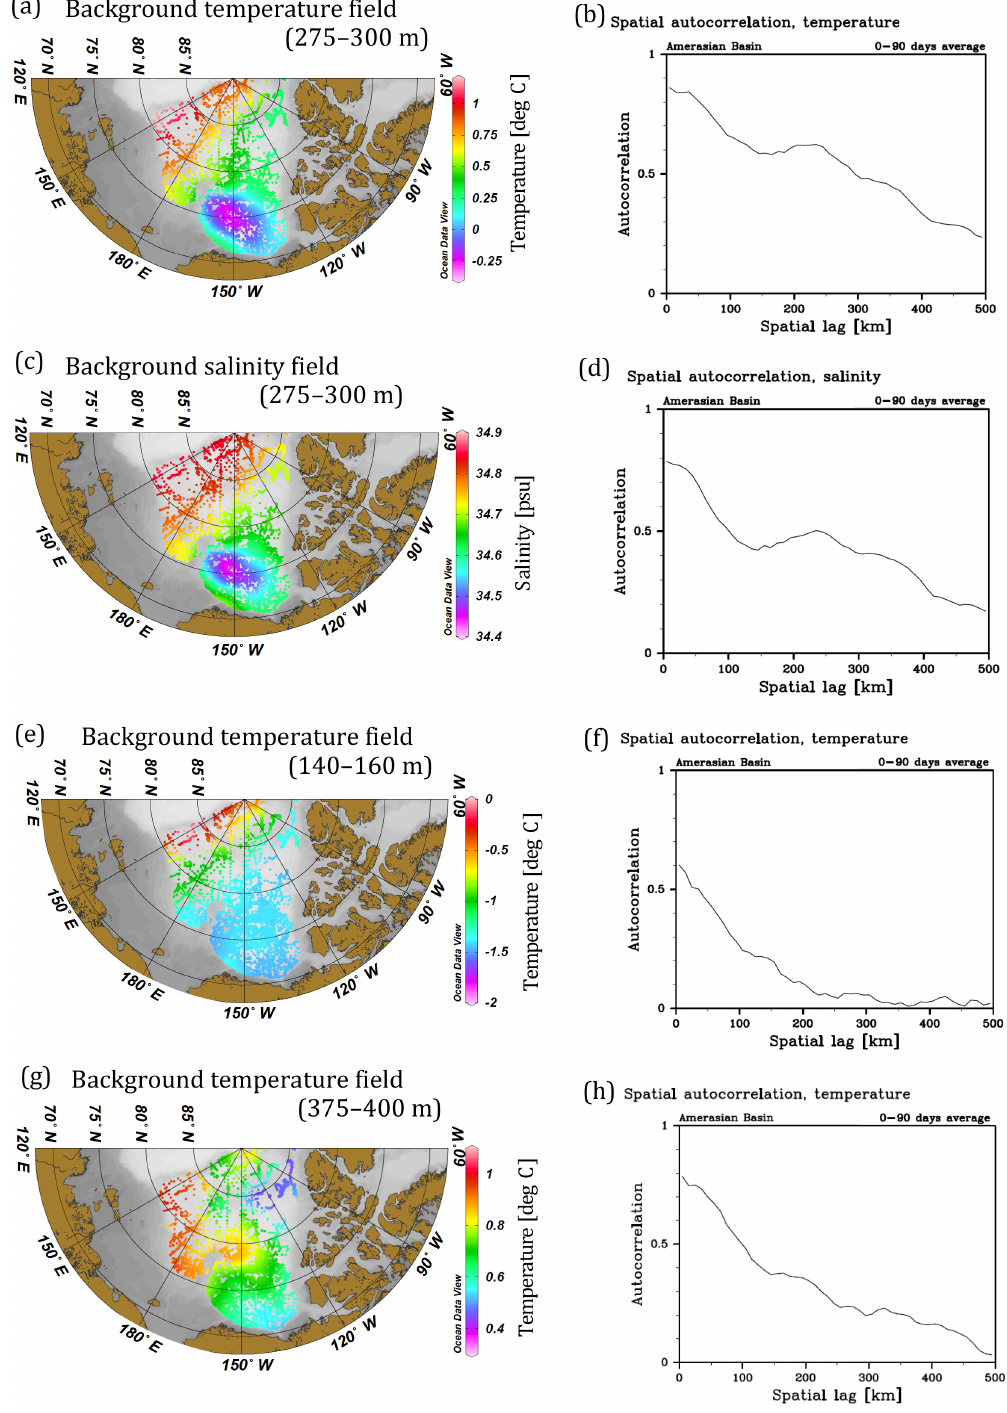
Figure C2. (a, c, e, g) Examples of the background mean fields with a circular structure associated with the Beaufort Gyre (a, c) and without the circular structure (e, g) . (b, d, f, h) Spatial autocorrelation functions corresponding to their right panels. Panels (a–b) and (e–h) show temperature, while (c–d) shows